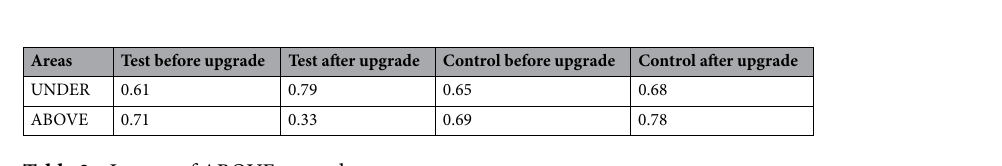
Table 2. Impact of ABOVE